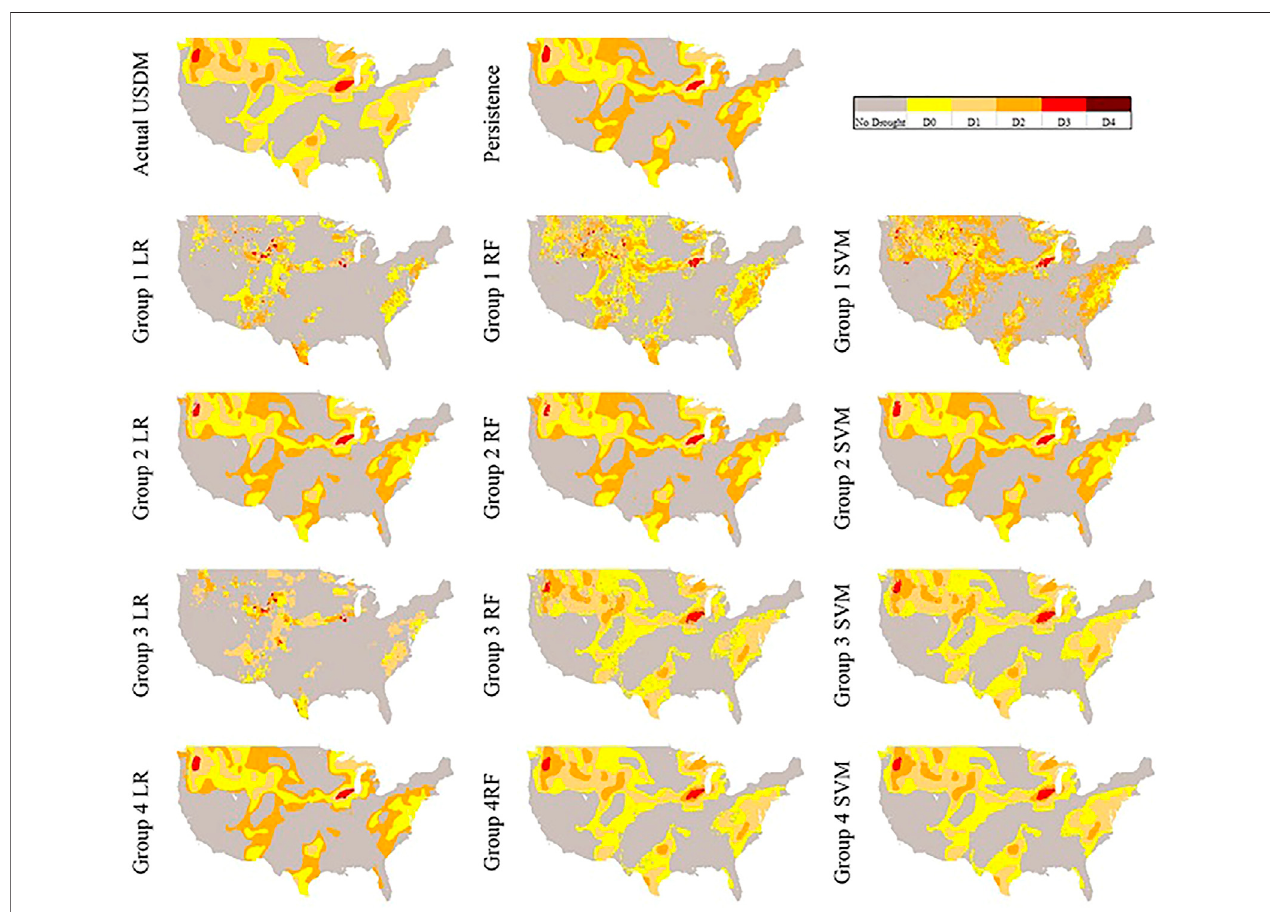
FIGURE 6 | Produced maps April 10, 2005 by each